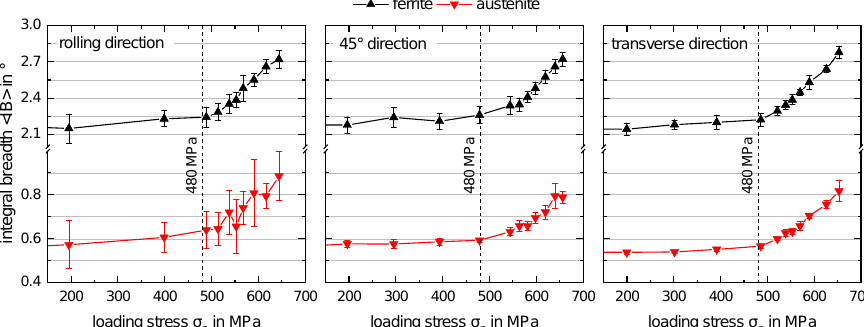
Figure 7. Evolution of integral breadths of the ferrite and austenite X-ray diffraction lines vs. the applied stress σ n in rolling direction ( left ), 45 ◦ direction ( center ) and transverse direction ( right